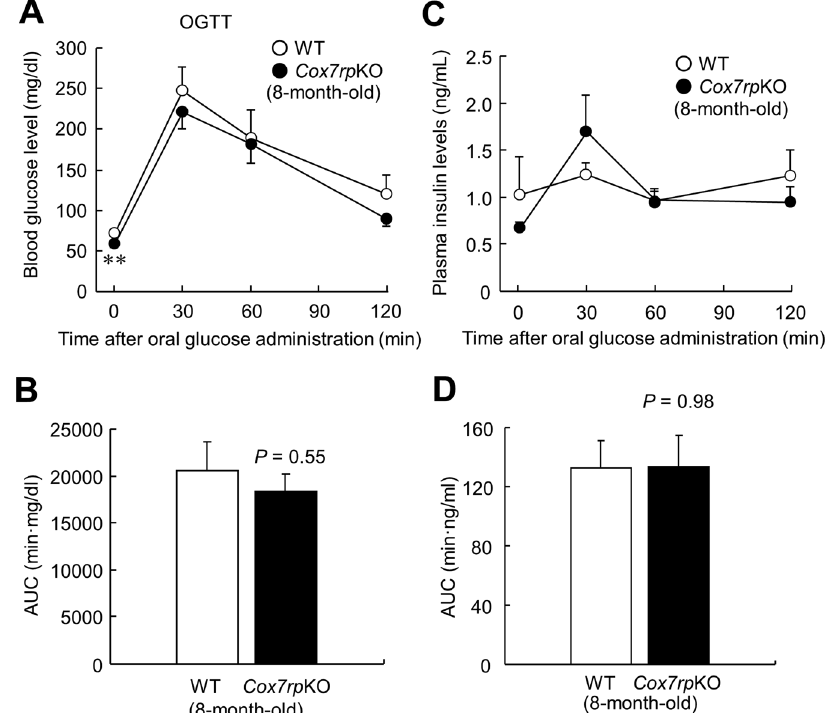
Figure 3. Lower blood glucose levels in 8-month-old Cox7rp KO mice versus WT mice during OGTT. ( A ) Blood glucose levels during OGTT were examined in 8-month-old Cox7rp KO and WT mice as described in Fig. 1. ( B ) AUC of blood glucose in OGTT. ( C ) Plasma insulin levels during OGTT. ( D ) AUC of plasma insulin in OGTT. Data are presented as means ± SEM ( n = 6). * P < 0.05, ** P < 0.01, using Student’s t